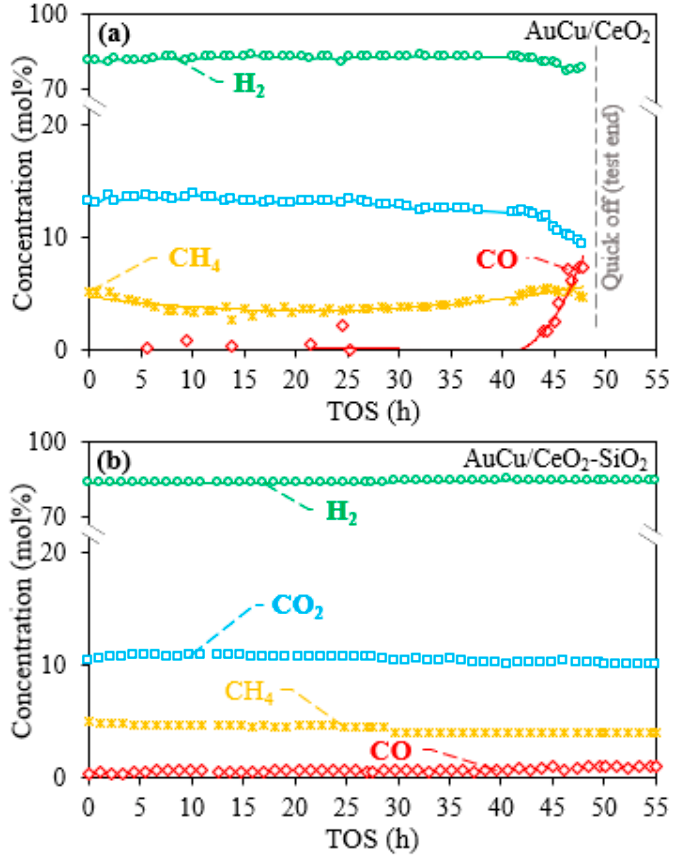
Figure 5. Products distribution obtained from a system that integrate the ESR reactor and the cleanup reactor, where the CO removal is performed with ( a ) AuCu / CeO 2 and ( b ) AuCu / CeO 2 -SiO 2 catalysts. Syngas feed: 7.8% H 2 , 2.0% CO, 0.5% CO 2 , 0.3% CH 4 , 1.4% H 2 O, 1.8% O 2 , 6.8% N 2 , and 79.4% Ar. Reaction conditions: The space velocity (SV) = 6.5 ± 0.2 L / g cat *min and 0.3 g of the catalytic bed. Note: TOS = Time-on-stream.